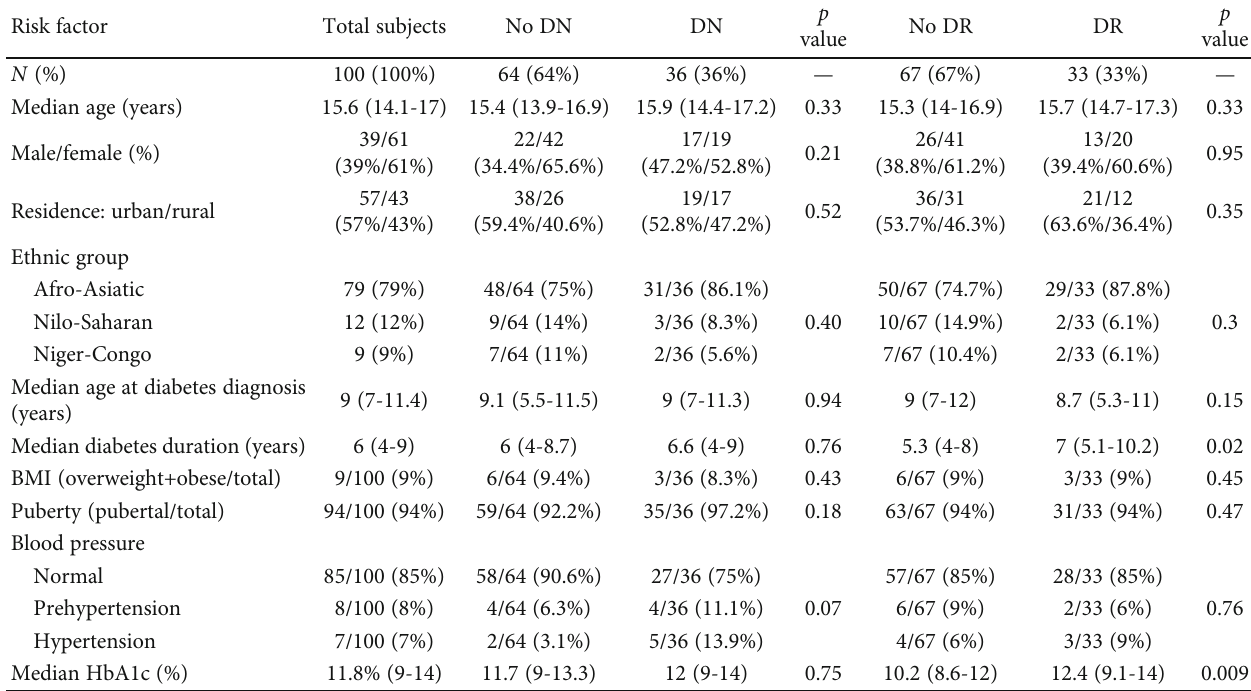
Table 1: Characteristics of the total participants and patients with and without nephropathy and retinopathy. Risk